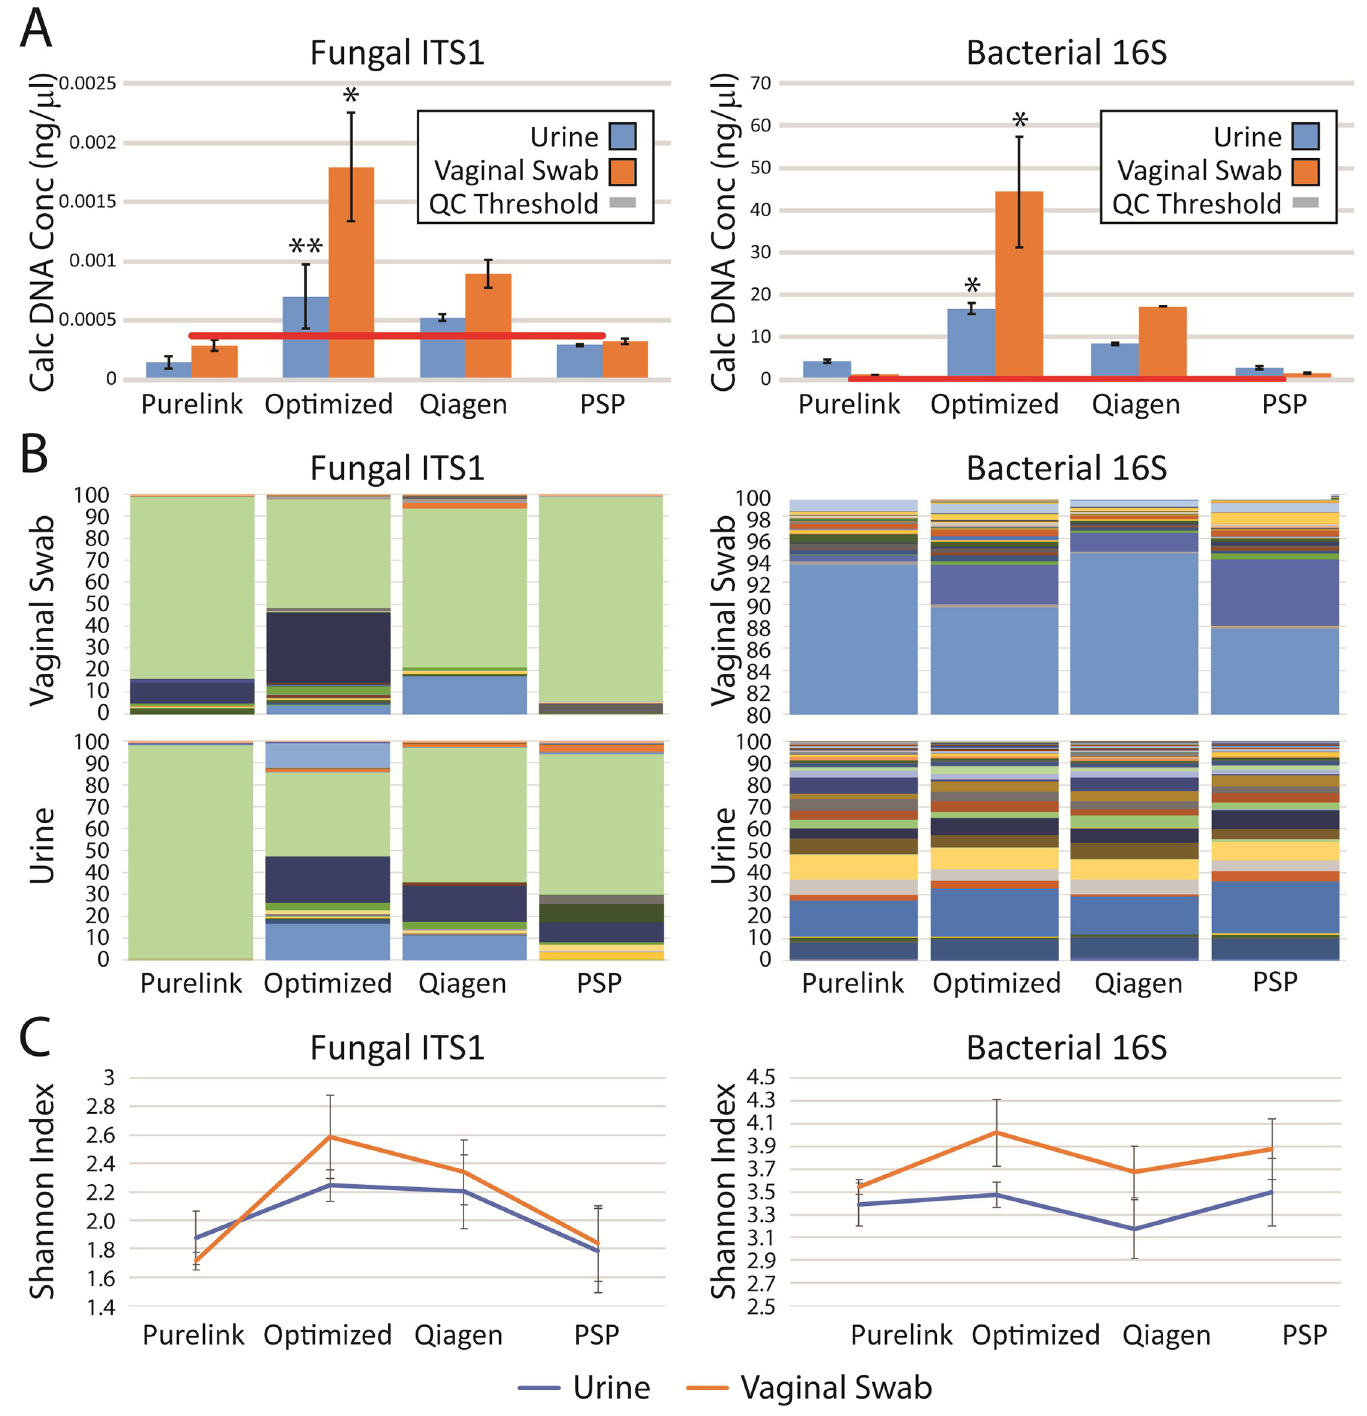
Fig 5. Our optimized DNA extraction method outperforms commercial methods. We compared fungal (left) and bacterial (right) extraction and characterization after our optimized protocol in comparison to three commercial DNA preparation kits using standardized urine and vaginal swab samples. (A) Individual urine specimens were divided into equal aliquots of 30 ml each. DNA was isolated from each aliquot using the specified methods; this process was repeated in quadruplicate. Samples were assessed by qPCR for fungal (left) and bacterial (right) DNA. Calculated DNA concentrations were determined by normalization to a mixed fungal and bacterial standard with a known DNA concentration. � : P < 0.001, �� : P < 0.005. (B, C) Samples were sequenced in quadruplicate by next generation sequencing for the ITS1 (left) and 16S (right) primers. (B) The stacked bar plots represent the mean relative abundances for the fungal (left) and bacterial (right) populations in individual sequencing runs. (C) Shannon diversity indices were calculated from the microbial populations resulting from NGS for each purification method.